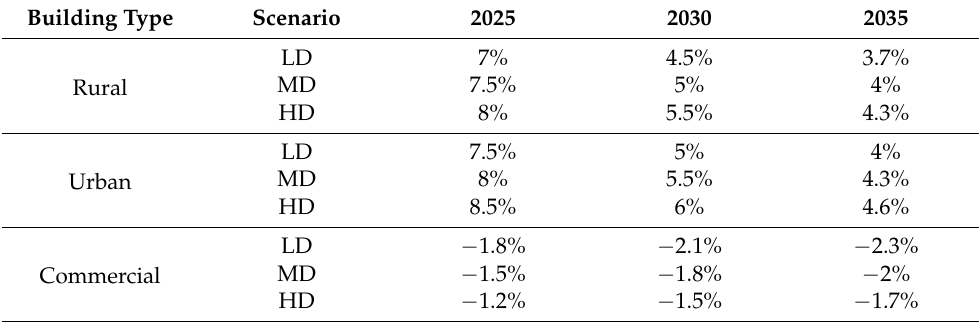
Table 3. Growth rate of construction area in Shandong Province from 2020 to